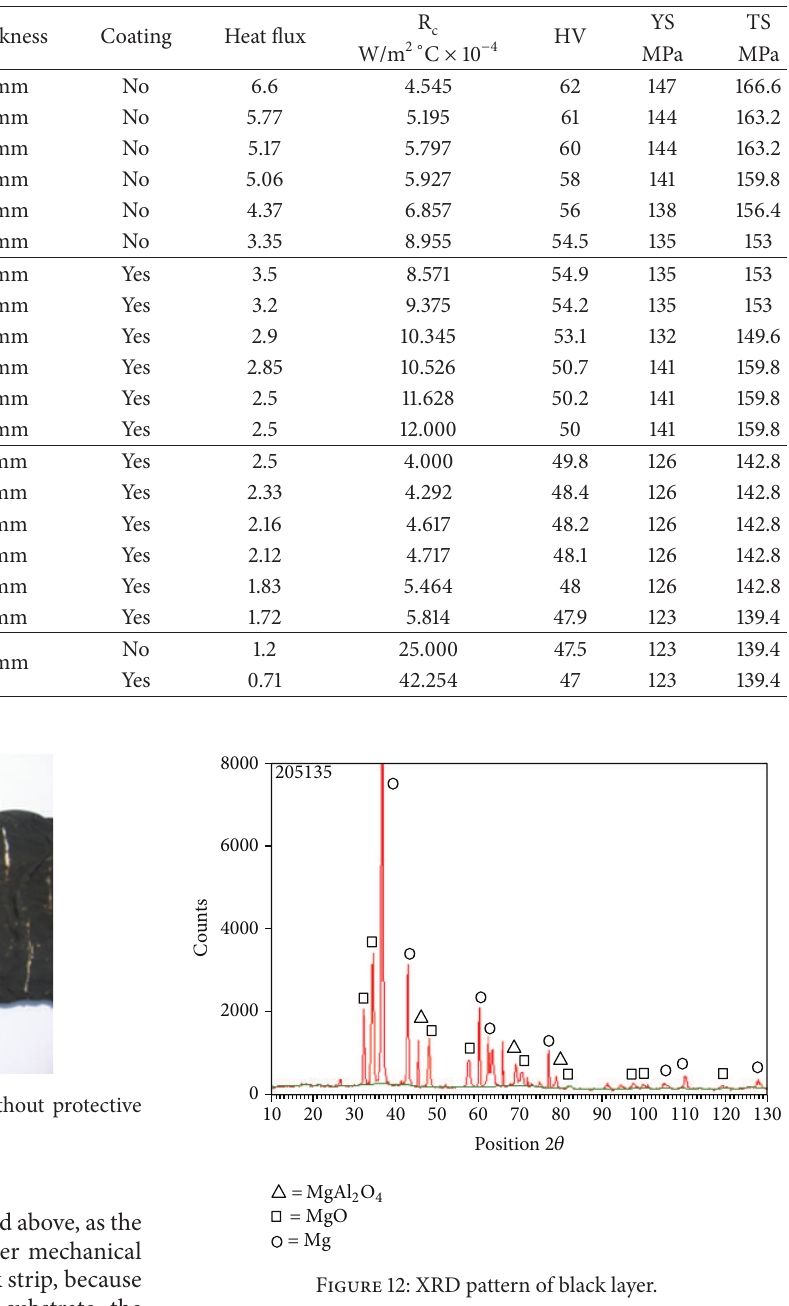
Table 6: Mechanical properties of AZ31-B strips.